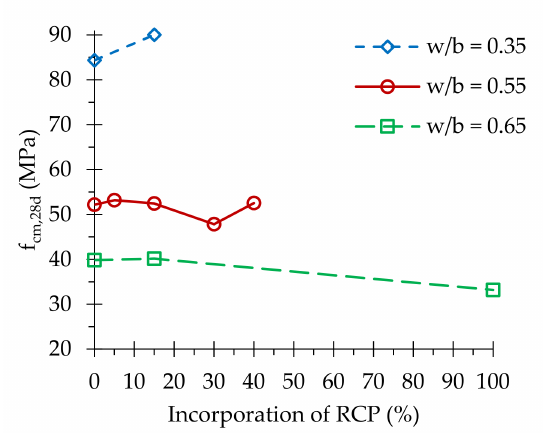
Figure 8. Compressive strength at 28 days, f cm ,28 d , of concrete with different incorporation percent- ages of RCP and